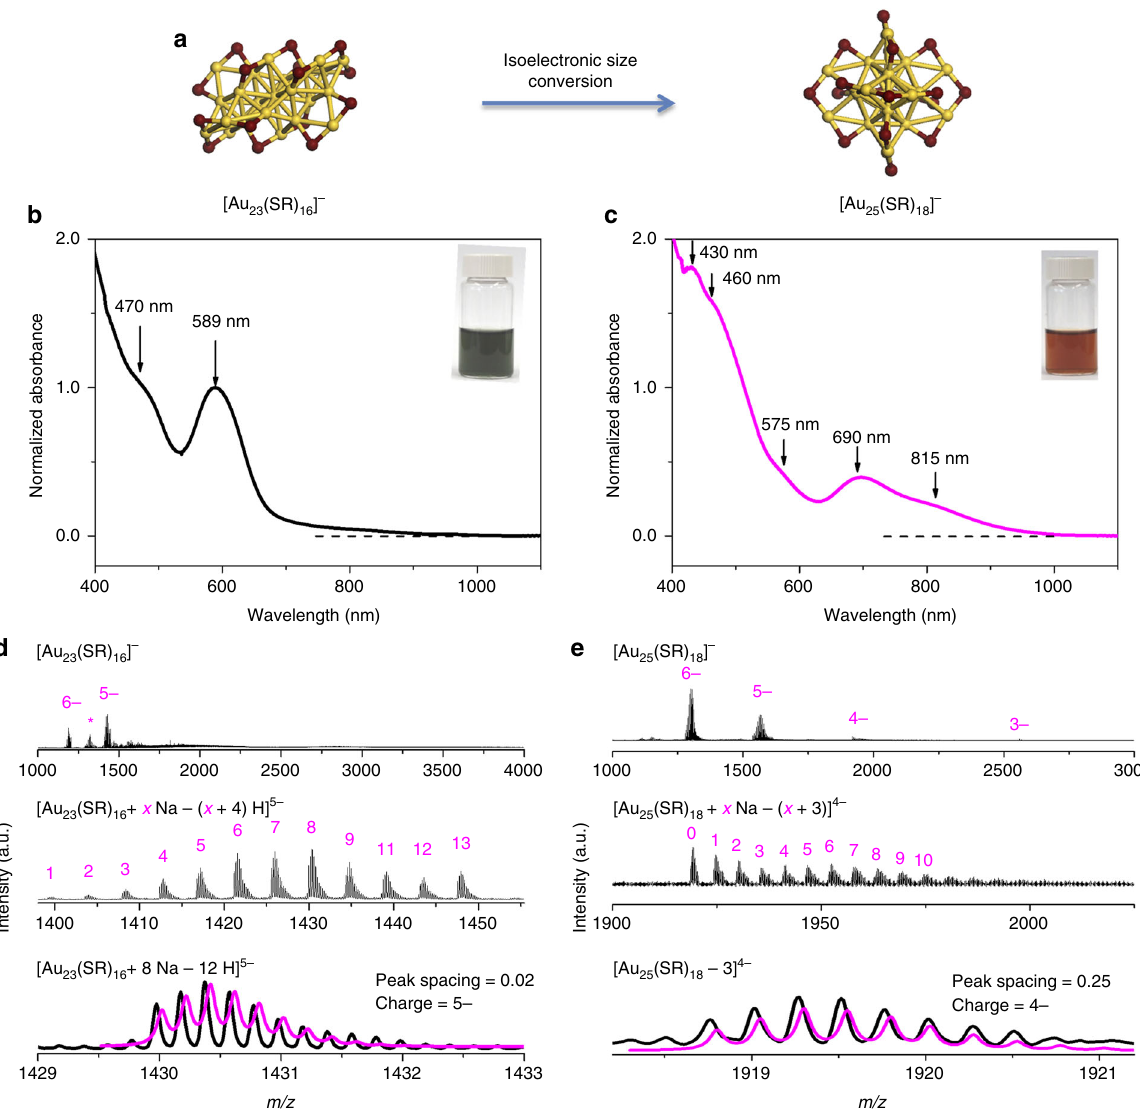
Fig. 1 Size conversion from Au 23 to Au 25 nanoclusters. a Schematic illustration of size-conversion reaction from [Au 23 (SR) 16 ] − to [Au 25 (SR) 18 ] − (yellow, Au; wine, S), where SR denotes thiolate ligand. b , c Ultraviolet-visible absorption and d , e electrospray ionization mass spectra of b , d [Au 23 (SR) 16 ] − and c , e [Au 25 (SR) 18 ] − . The crystal structures of [Au 23 (SR) 16 ] − and [Au 25 (SR) 18 ] − are drawn according to the reported Au 23 S 16 56 and Au 25 S 18 13 skeletons, where all hydrocarbon tails are omitted for clarity. Insets in b , c are digital photos of the corresponding cluster solution. The magenta lines in d , e show simulated isotope patterns of the labeled cluster formulas, which match perfectly with the corresponding experimental